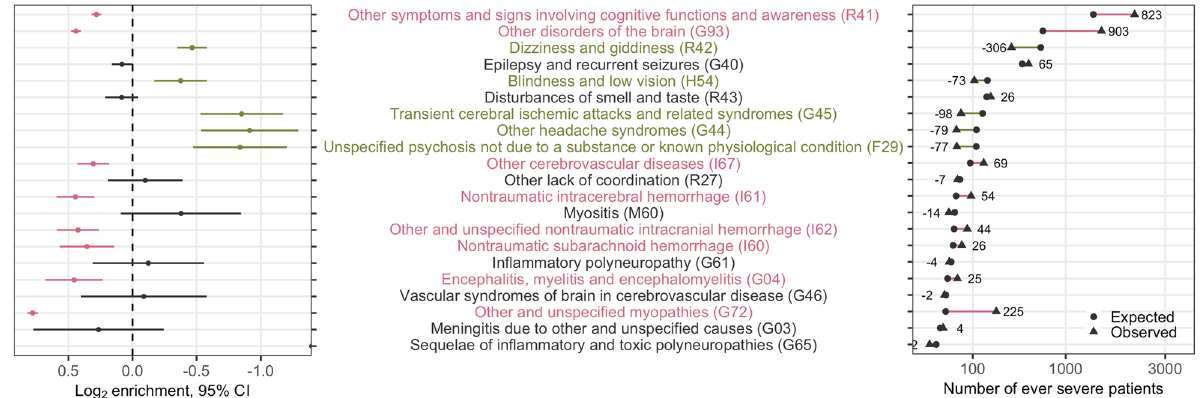
Figure 4. Analysis of enrichment or depletion of neurological conditions after admission in patients with severe disease. For each neurological ICD-10 code, we show the log 2 enrichment (LOE) and its 95% confidence interval (left), and the absolute difference between the observed (filled triangle) and expected ( ⋅ ) number of patients experiencing severe COVID-19 in square-root scale (right). A purple positive LOE value for an ICD-10 code indicates a statistically significantly higher proportion of severe cases having a given neurological ICD-10 code when compared to the never-severe cases. Conversely, a green negative LOE value indicates a statistically significantly lower proportion of severe cases having a given neurological ICD-10 code when compared to the never-severe cases. Neurological ICD-10 codes are ordered by the expected number of severe cases after admission.